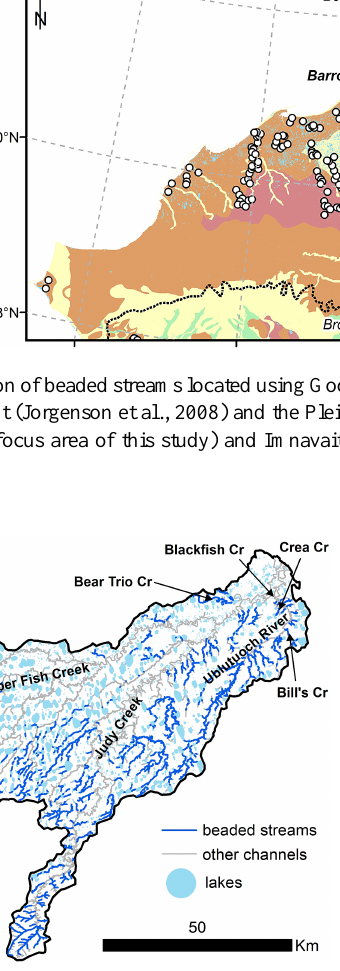
Figure 3. The drainage network of Fish Creek watershed (location shown in Fig. 2) showing all beaded stream networks that were de- lineated from 2.5m CIR photography. River systems and individual beaded stream catchments where more detailed field and geospatial studies were conducted for this study are